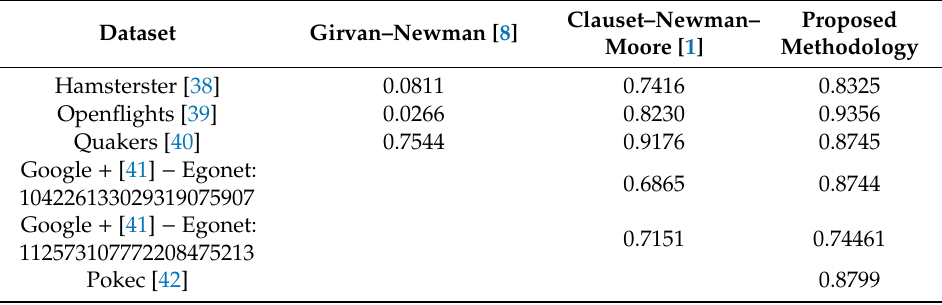
Table 5. Average generated community performance